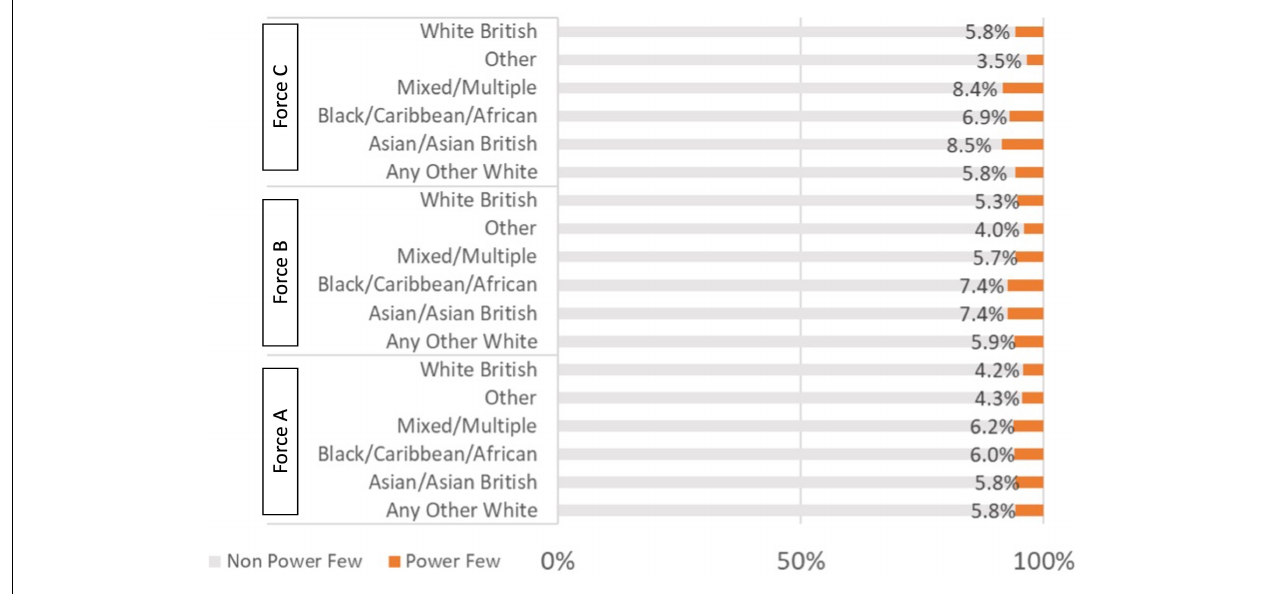
FIGURE 1 | Comparison of repeat suspect rates across ethnicity bands.